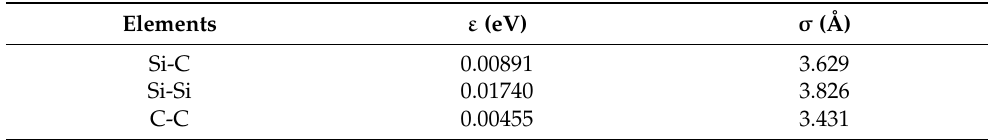
Table 1. Lennard-Jones